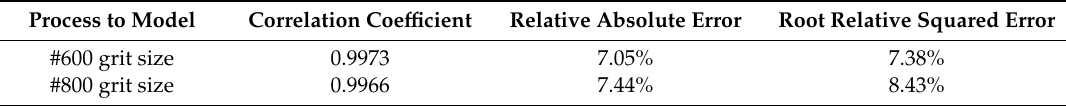
Table 5. The modeling error of machine learning-based process